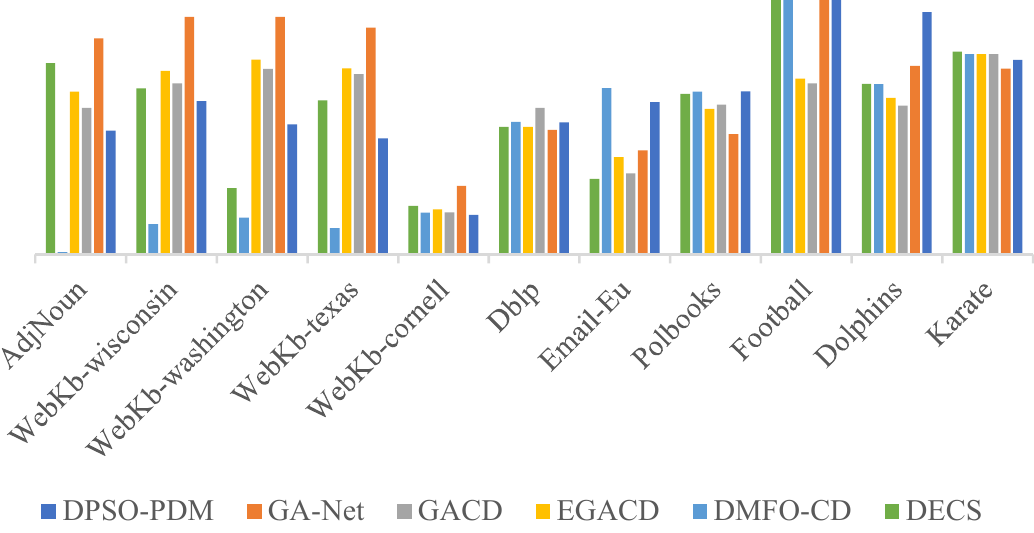
Figure 11. The average NMI of real-world network datasets.